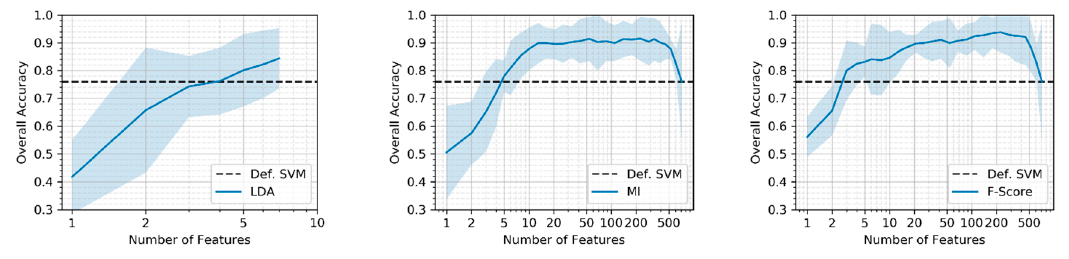
Figure 11. Overall accuracy as function of the numbers of features (Beijing).